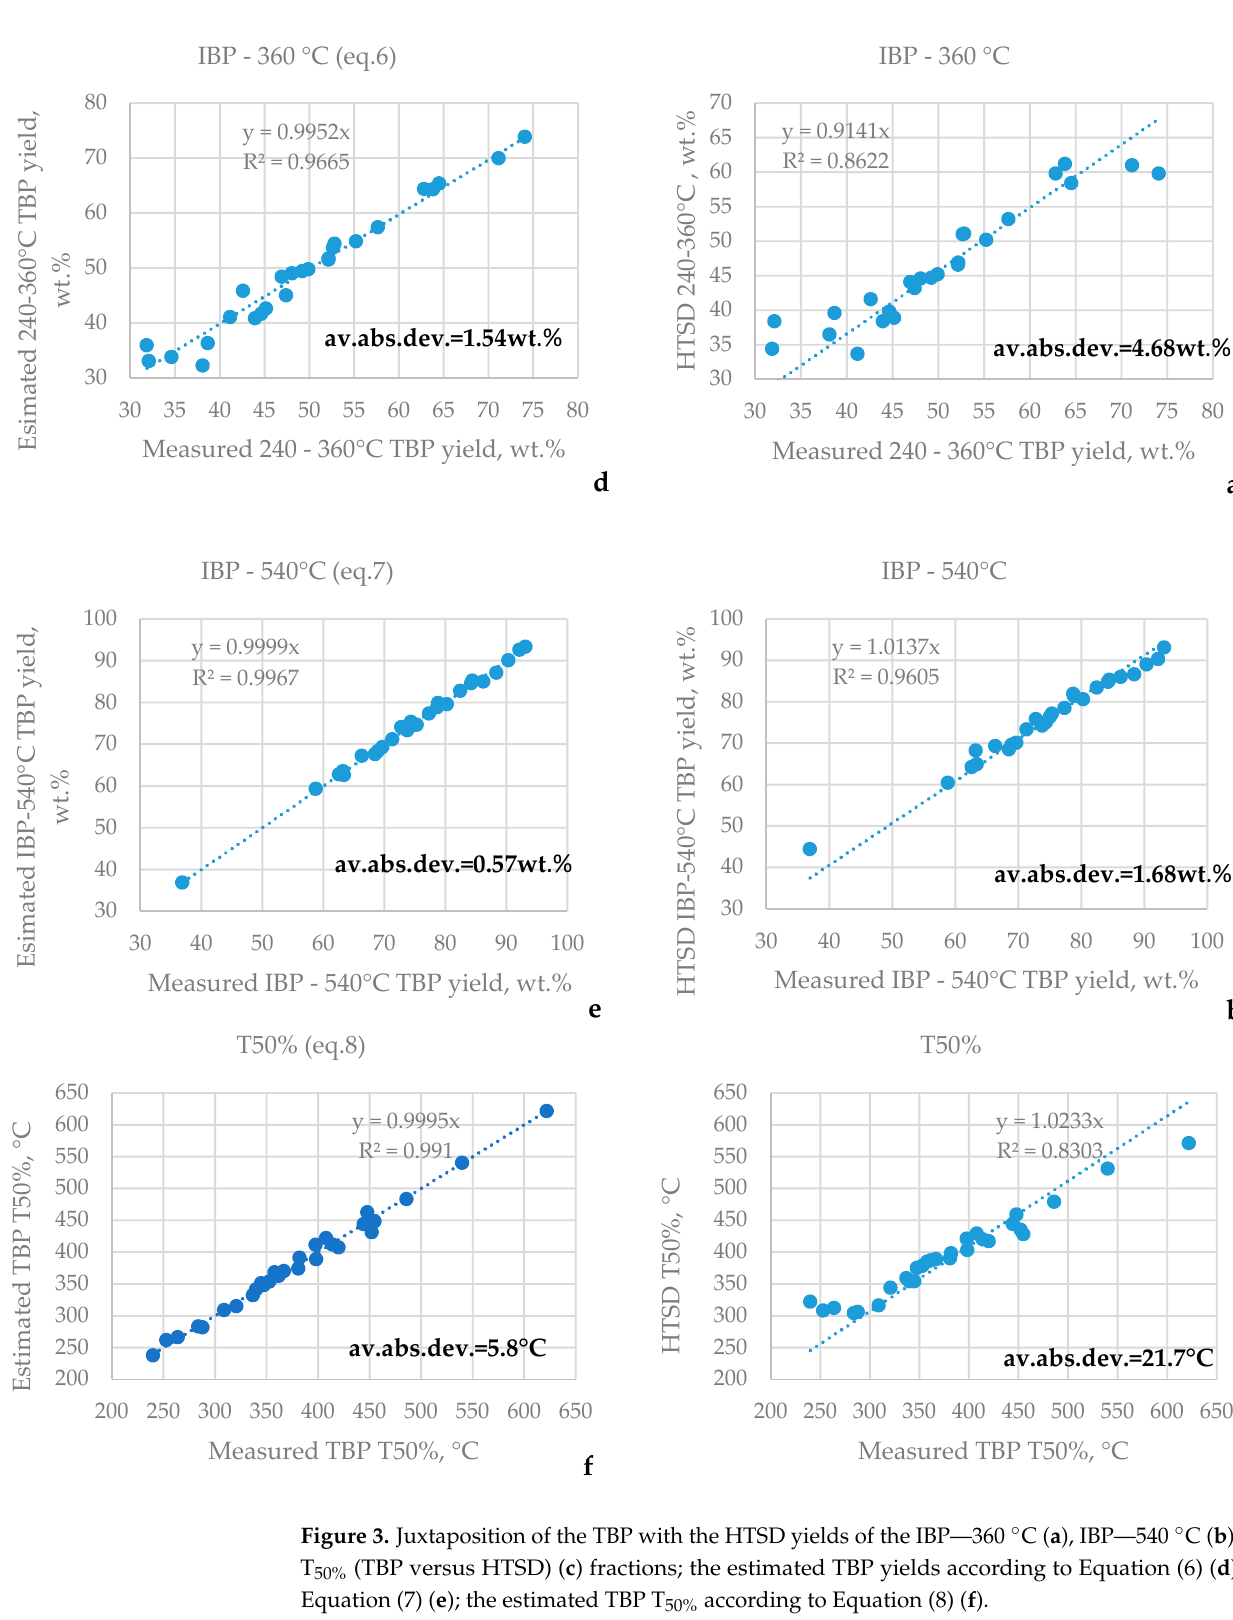
Figure 2. Juxtaposition of the TBP with HTSD yields of the 110–180 °C ( a ), 180–240 °C ( b ), and 240– 360 °C ( c ) fractions; the estimated TBP yields according to Equation (3) ( d ), Equation (4) ( e ), and Equation (5) ( f ).